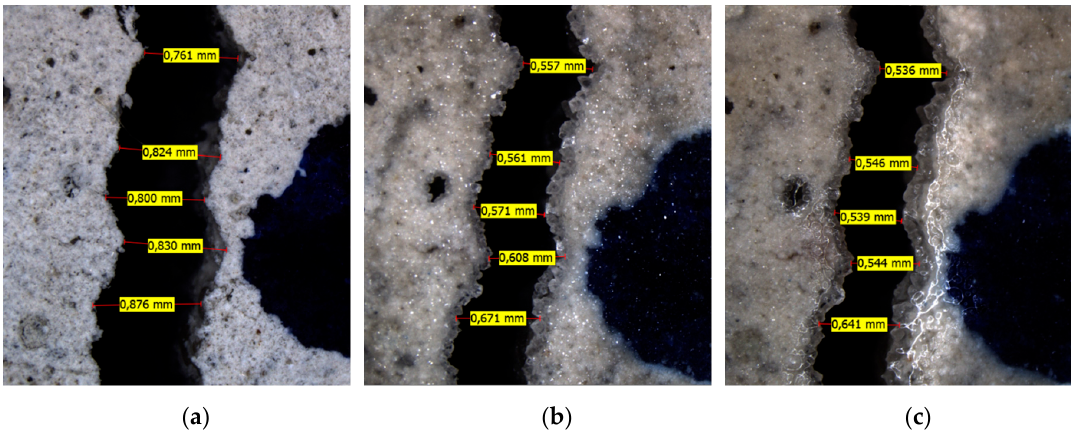
Figure 12. Crack location on the bottom faces of a specimen subjected to W/D cycles ( a : initial, b : 3 weeks of healing, and c : 6 weeks of healing).